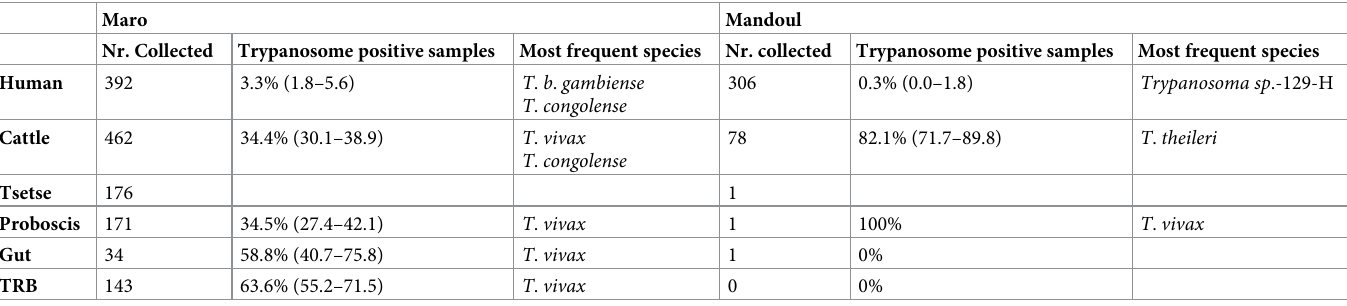
Table 2. Overview of trypanosomes frequency (in %) in humans, cattle and tsetse. The lower and upper limits of the 95% confidence interval are indicated in parentheses. Maro Mandoul Nr. Collected Trypanosome positive samples Most frequent species Nr. collected Trypanosome positive samples Most frequent species Human